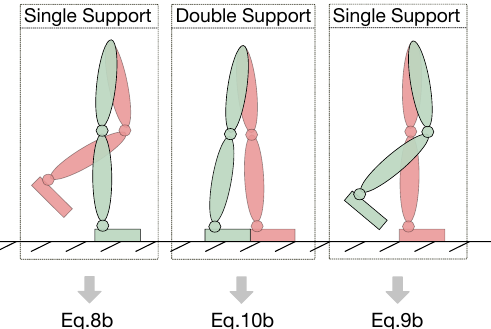
Figure 5. Classification of feet contacts: ( left ) single support on the right foot; ( middle ) double support; and ( right ) single support on the left foot.